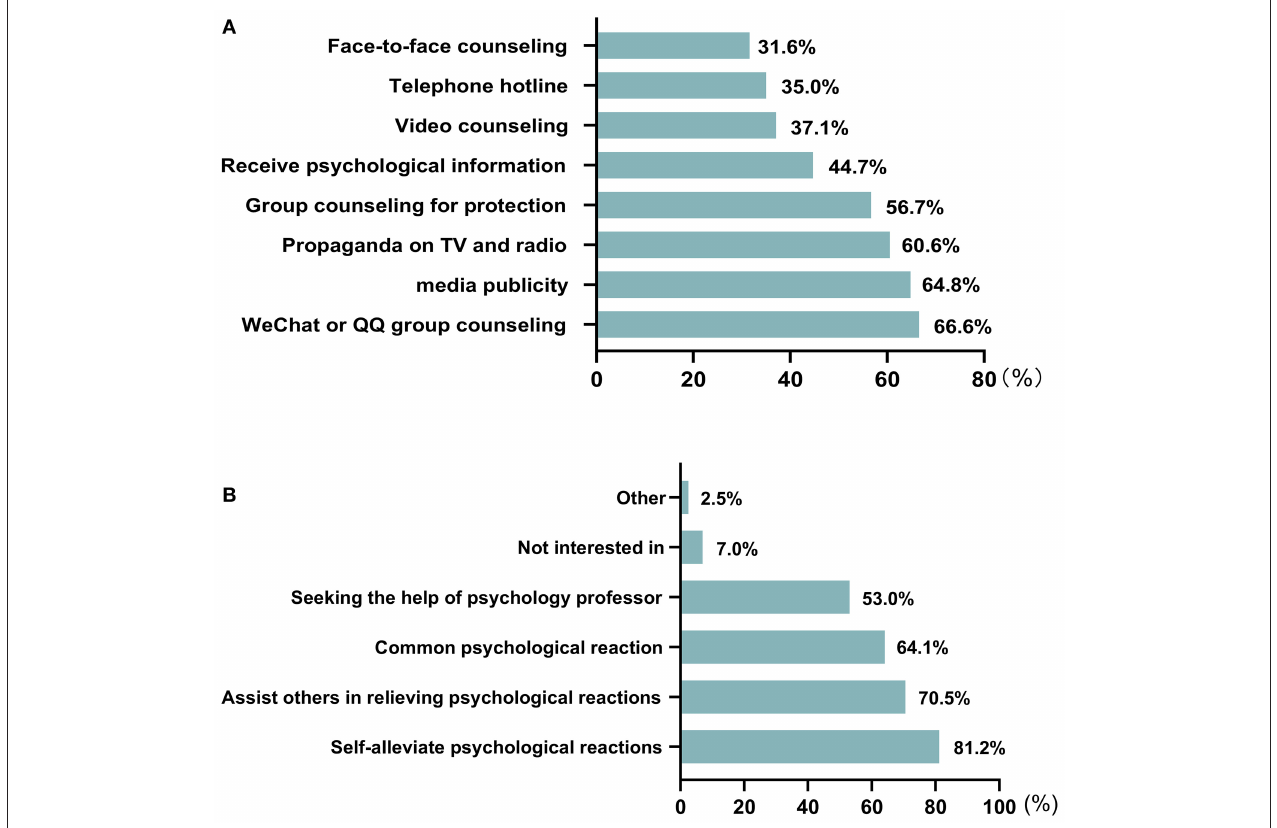
FIGURE 1 | Findings on the psychological aid needs. (A) The choice of medical staff for psychological aid forms. (B) The choice of medical staff for content of psychological